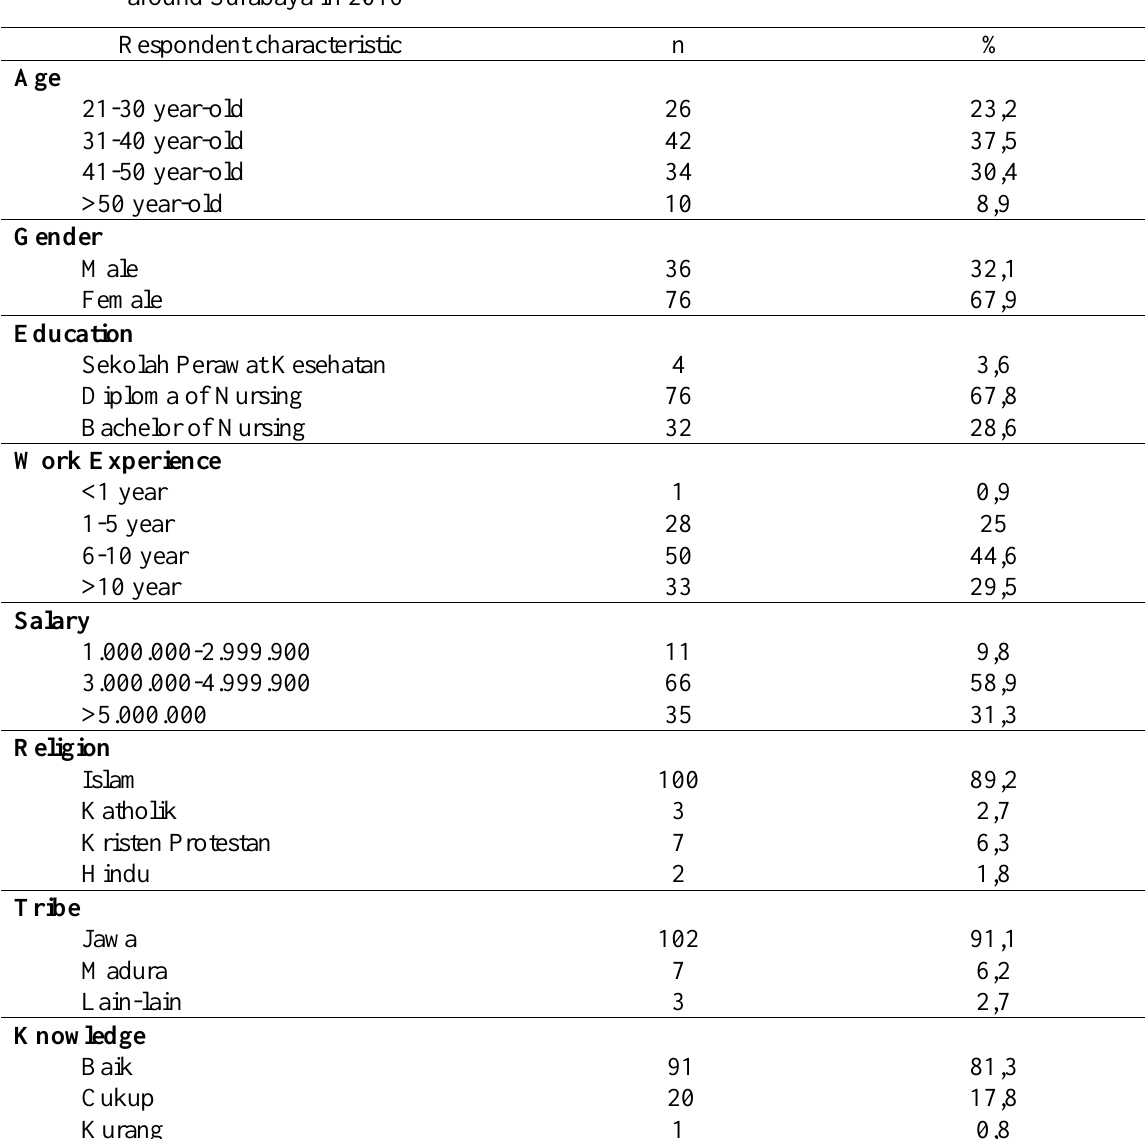
Table 1. Personal information and background the study of Nurse Behavior in Implementation of Diabetes Mellitus Education Based on Theory of Planned Behavior in Public health center around Surabaya in